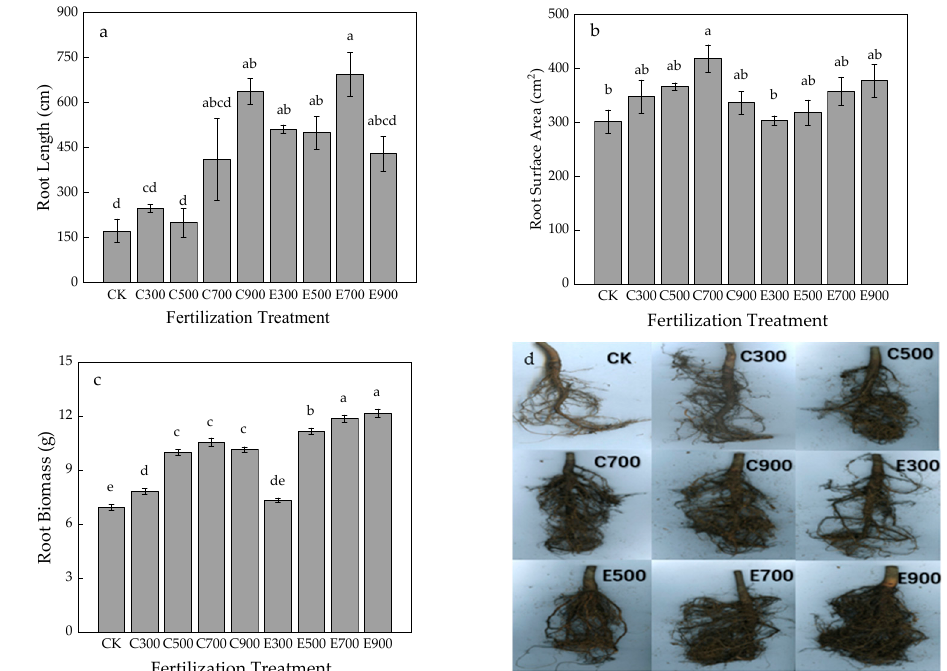
Figure 2. Effects of fertilization on root system of Q. nuttallii container seedlings ( a – c ), and root morphology of each treatment ( d ). Lowercase letters represent significance at 0.05 level and the same letter indicates no significant difference in full text.